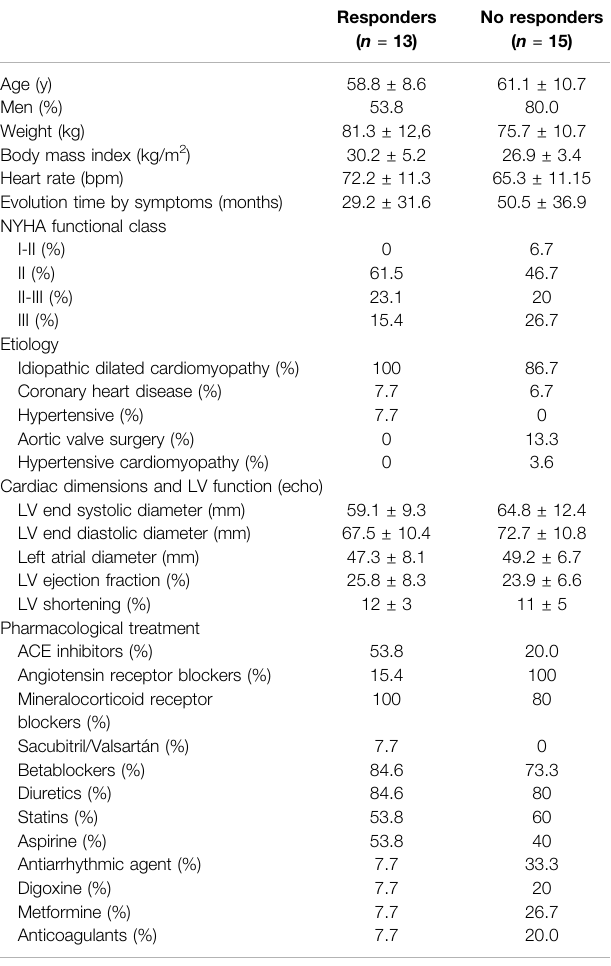
TABLE 1 | Baseline functional class, demographics, heart rate, etiology, cardiac dimensions and LV function and pharmacological treatment in Responders and Non Responders HFrEF patients ( n (cid:1)